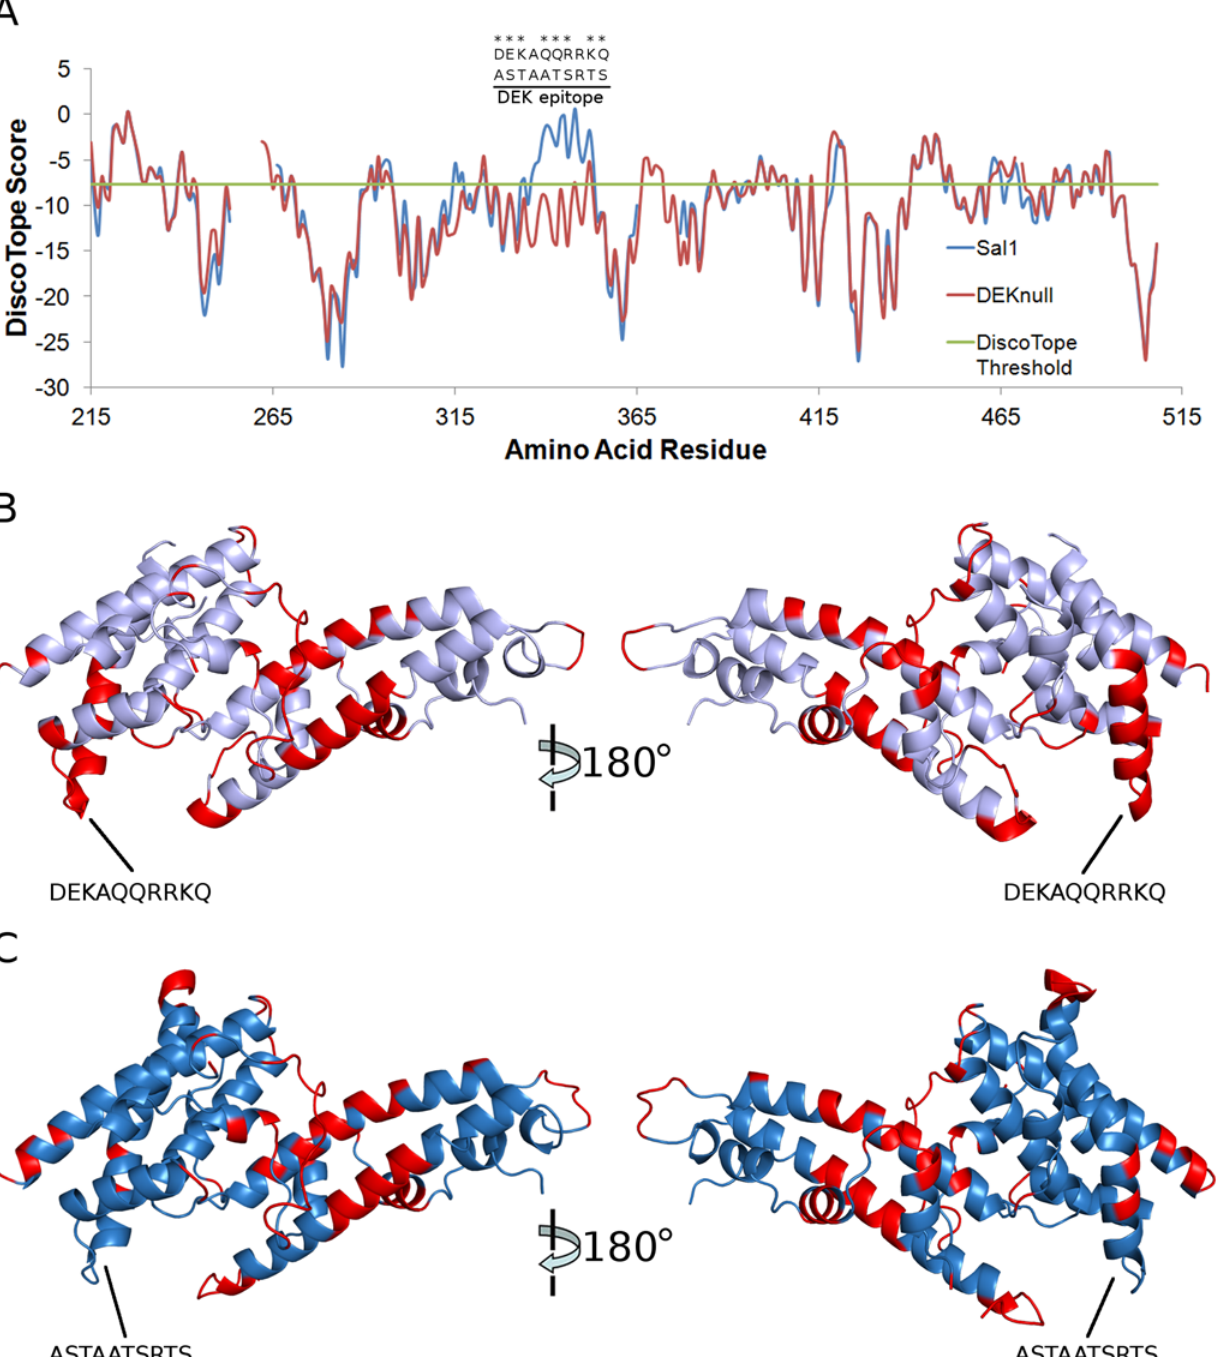
Fig 4. DiscoTope B-cell epitope prediction of Sal1 DBP-II and DEKnull. (A) Graphical representation of DiscoTope B-cell epitope scores for Sal1 DBP-II (blue line) and DEKnull (red line). Prediction threshold is shown in green. DEK residues are located at amino acids 339 – 348 and shown above the corresponding location in the graph. (B) Two views of Sal1 DBP-II predicted epitopes mapped onto crystal structure. (C) Two views of DEKnull predicted epitopes mapped onto crystal structure.